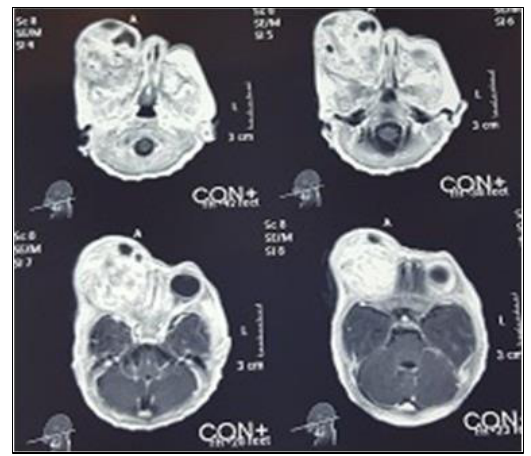
Figure 2: Axial T1 post contrast MRI: showing a hetero- genous mass in right orbit with globe displacement. The incision was passed through the skin and orbicu-